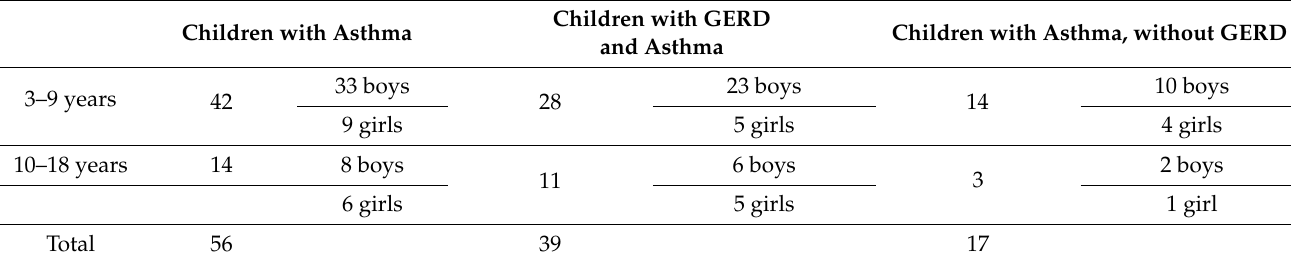
Table 2. Distribution of cases by